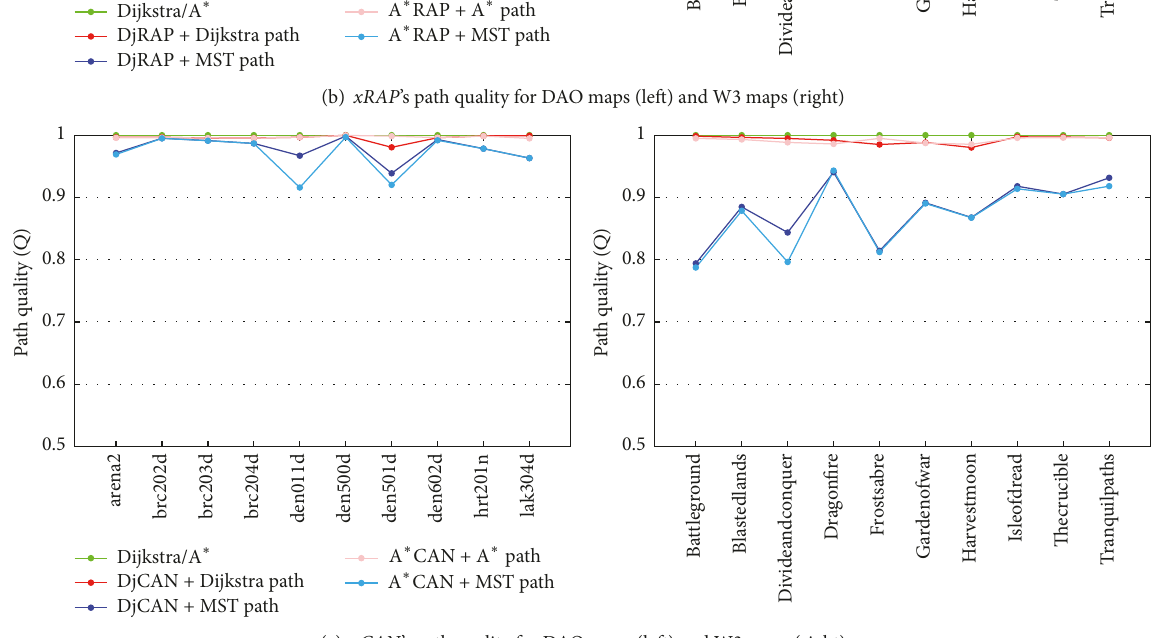
(b) xRAP ’s path quality for DAO maps (left) and W3 maps (right)